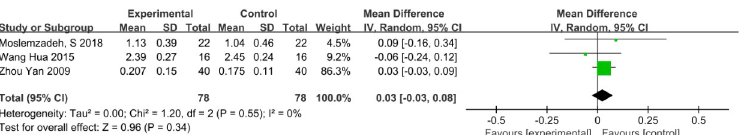
Fig 5. The status of GI index at 6 months between the VFR group and the Hawley group after excluding a large heterogeneity study.